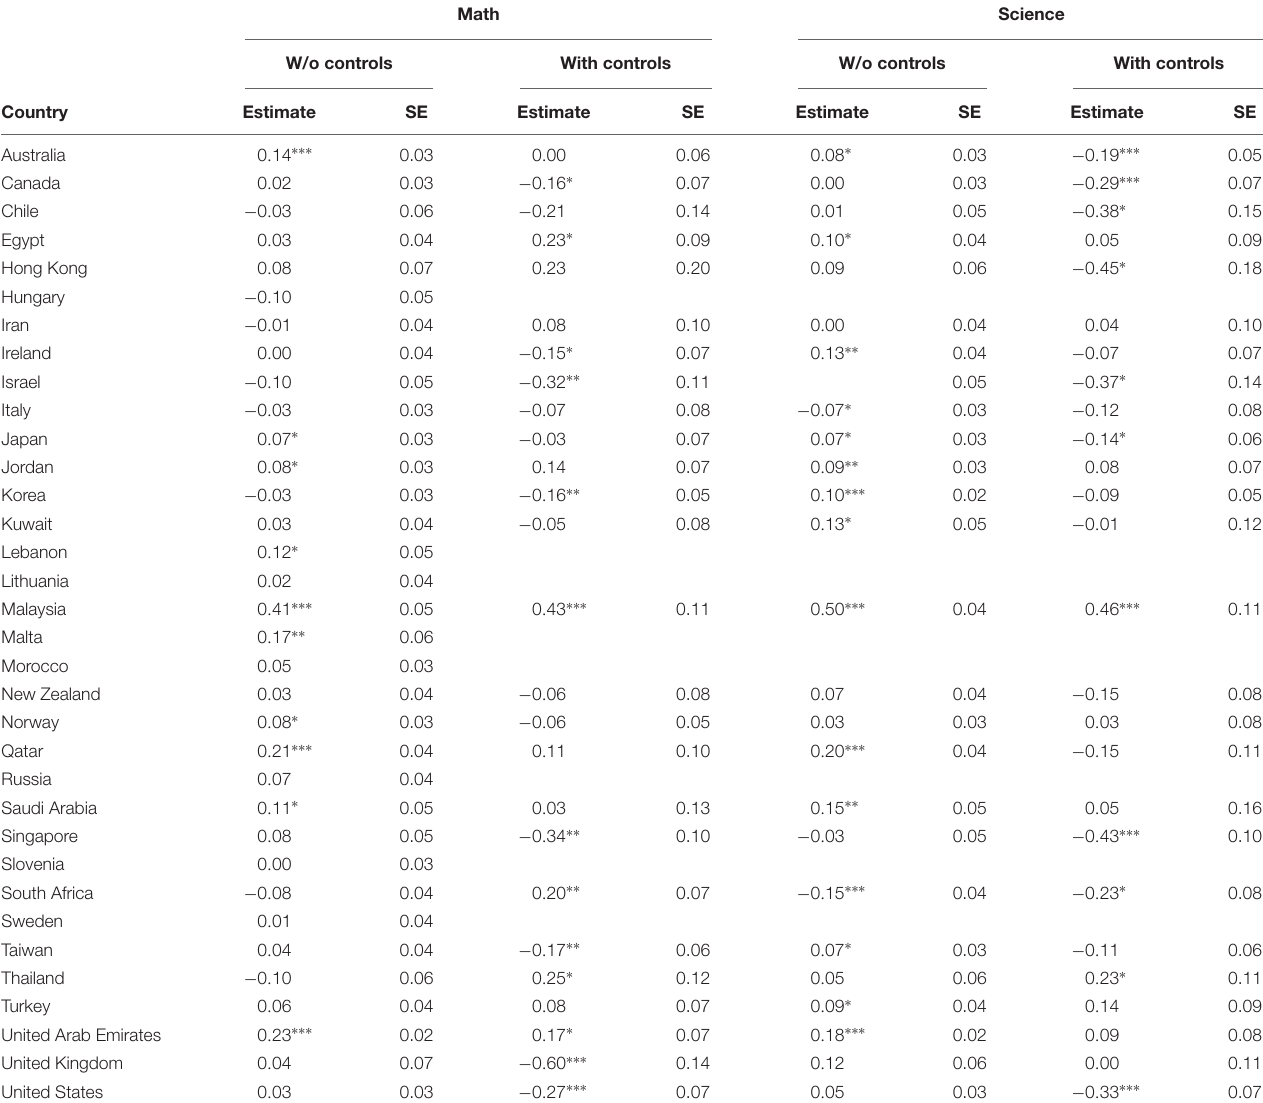
TABLE 4 | Estimates of the MBF effect on achievement in Grade